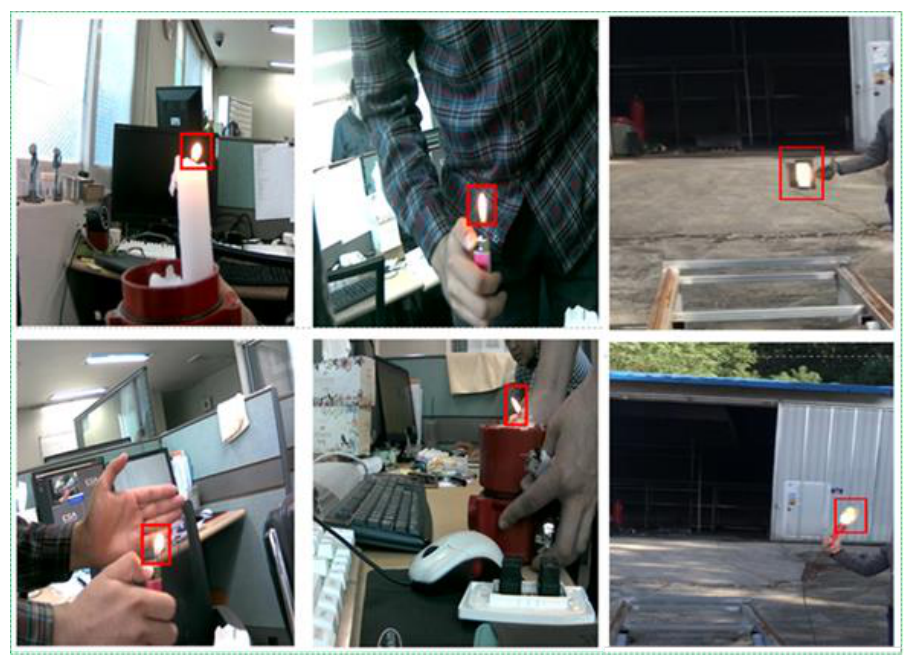
Figure 11. Small size fire region images for the training dataset.